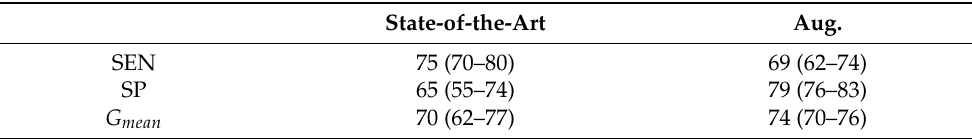
Table 8. Comparison between state-of-the-art results and the obtained with the augmented data set, presented as medians and interquartile